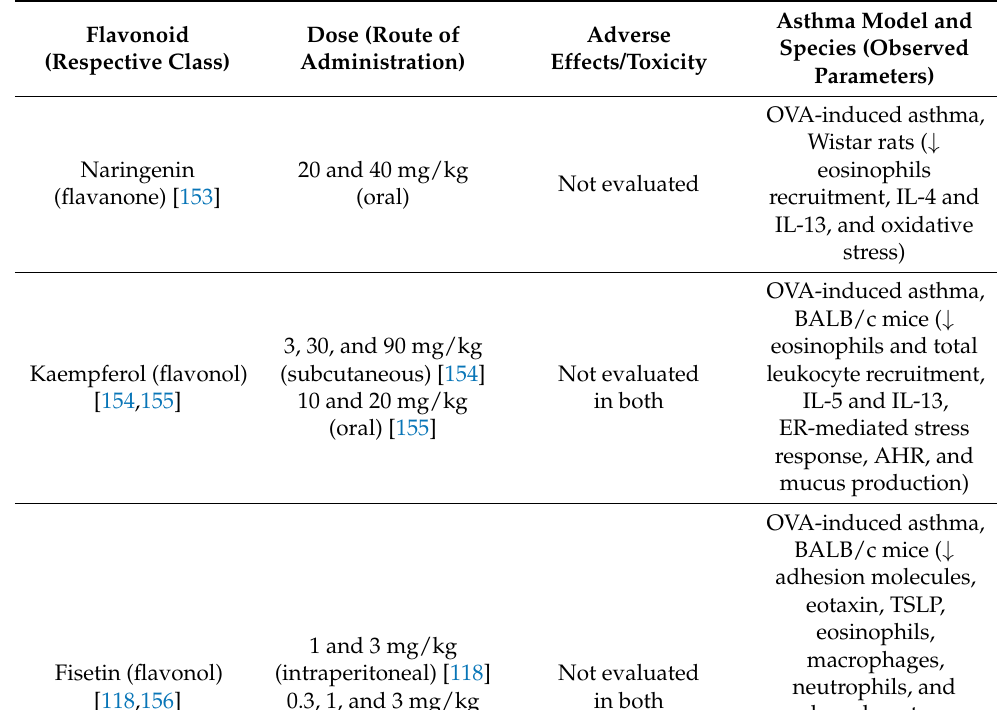
Table 2. Some of the flavonoids with therapeutic activity in asthma models to which controlled release systems could be